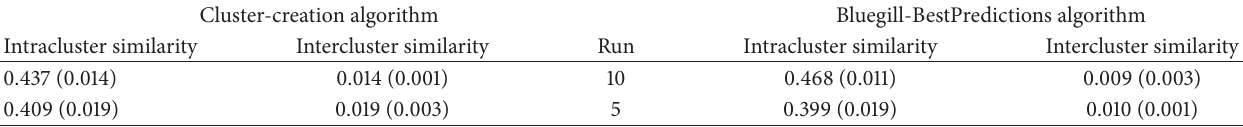
Table 1: Average results of 10 runs of WebBluegillRecom-annealing algorithm with ICTF = 0.1 and Clus threshold = 10 .